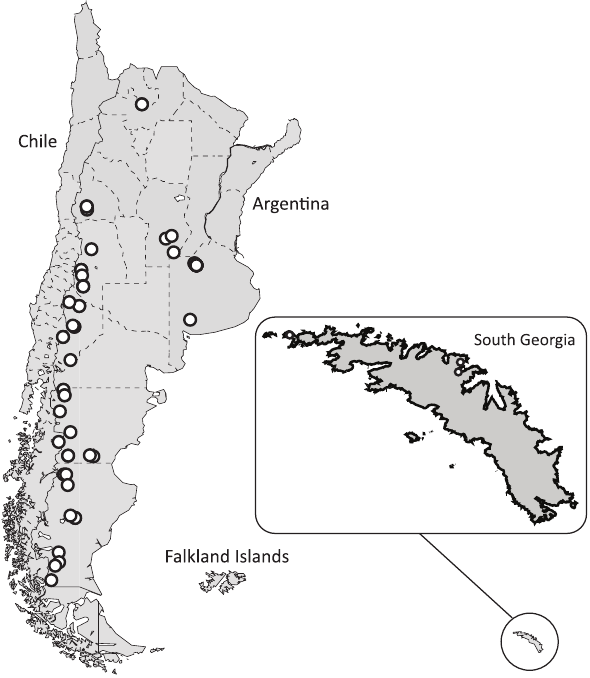
Figure 1. Map illustrating the localities of pintail samples on South Georgia and in Argentina (speckled teal localities are shown in figure 1 of McCracken & Wilson [17]).